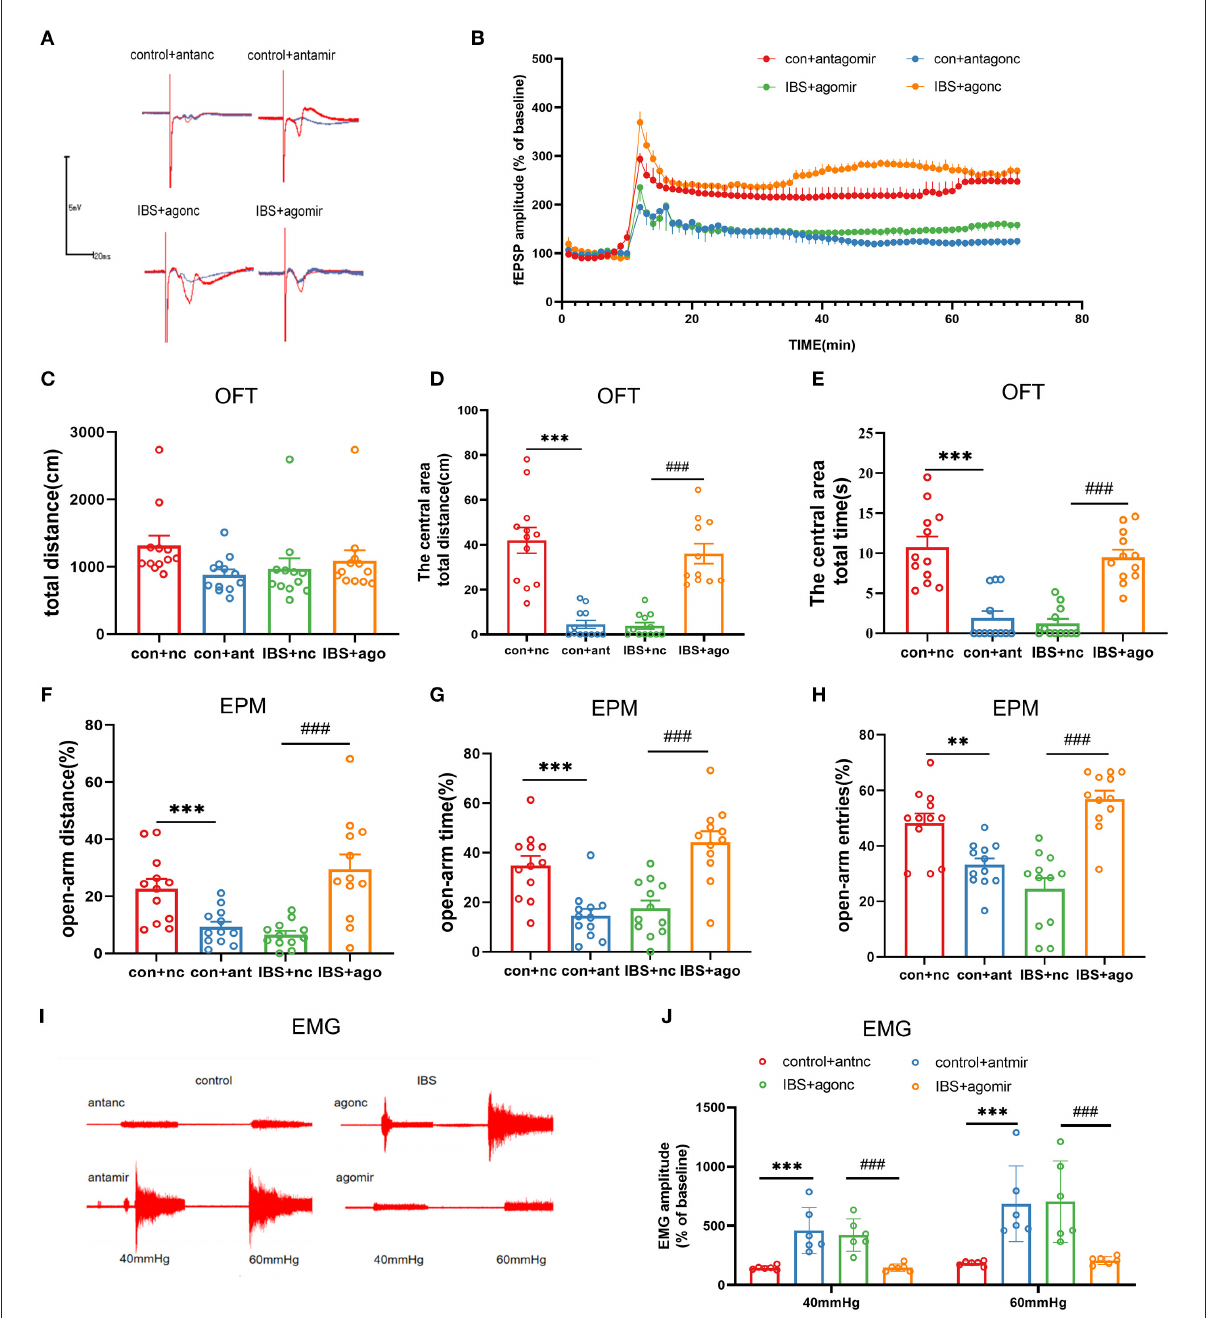
FIGURE5 CA1 miR-124-3p upregulation decreased LTP, visceral hypersensitivity and anxiety in IBS-like rats while miR-124-3p blockade induced LTP, visceral hypersensitivity and anxiety in control rats. (A,B) Sample waveforms and summary bar charts of field potential before and 60min after HFS in the slices of hippocampus. N = 3, * P < 0.05. Statistical analysis of the total distance (C) , the distance (D) and time (E) in the central area of the OFT. N = 12, *** p < 0.001, ### p < 0.001. Statistical analysis of the distance (F) , the time (G) , and the number of entries (H) in the open arm of EPM. N = 12, ** p < 0.01, *** p < 0.001, ### p < 0.001. (I) The original typical recordings of EMG at 40 and 60 mmHg CRD. (J) The statistical chart of the percentage of EMG amplitude over baseline. N = 6, *** p < 0.001, ### p < 0.001. CRD, colorectal distension; EMG, electromyography; EPM, elevated plus maze test; HFS, high-frequency stimulation; IBS, irritable bowel syndrome; LTP, long-term potentiation; OFT, open field